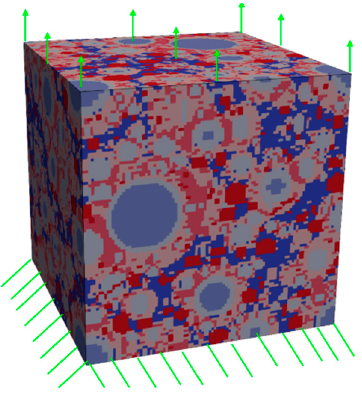
Figure 2. Example of the microstructure and the boundary conditions in the simulated uniaxial tensile test.